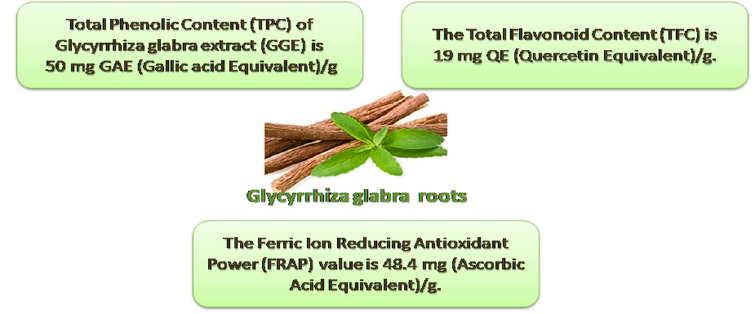
Figure 2. TPC, TFC, and FRAP in Glycyrrhiza glabra methanolic extract.